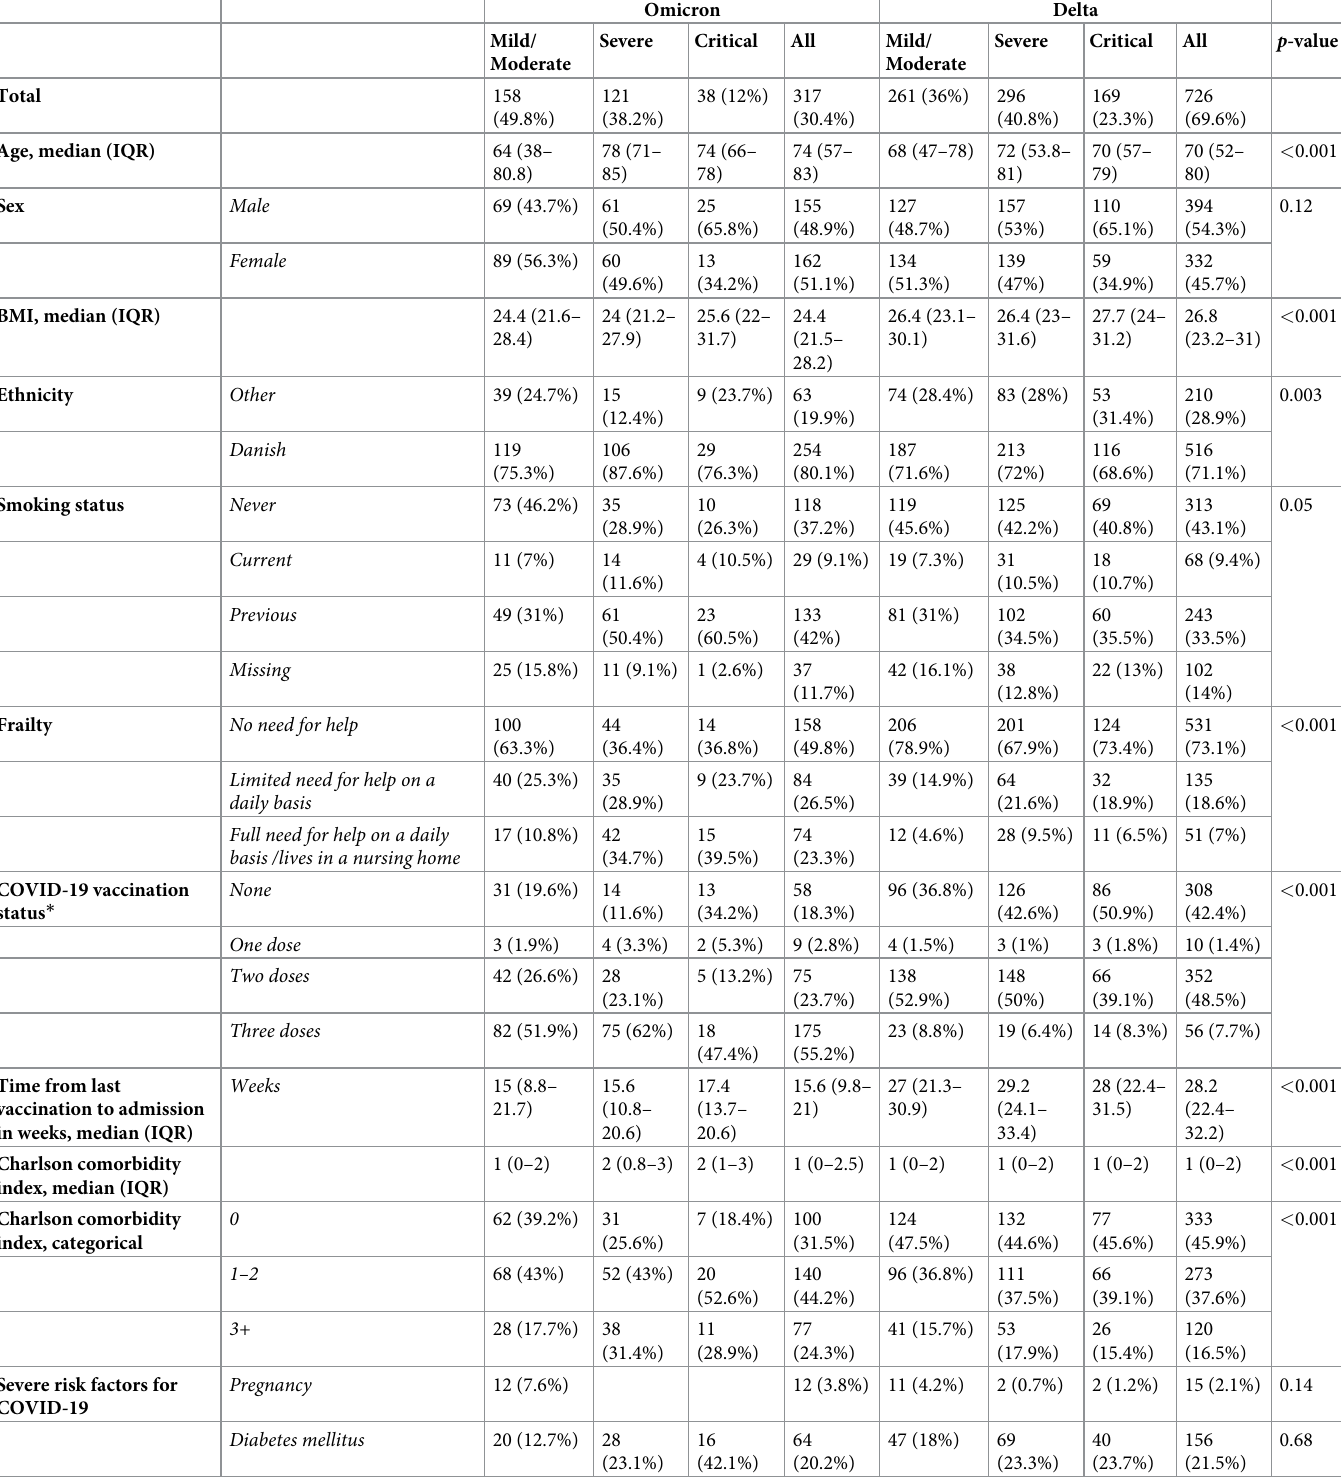
Table 1. Baseline characteristics of patients hospitalized with COVID-19 due to SARS-CoV-2 Omicron and Delta variants, according to disease severity (Copenha- gen, 1 September 2021 to 11 February 2022; n = 1,043). Omicron